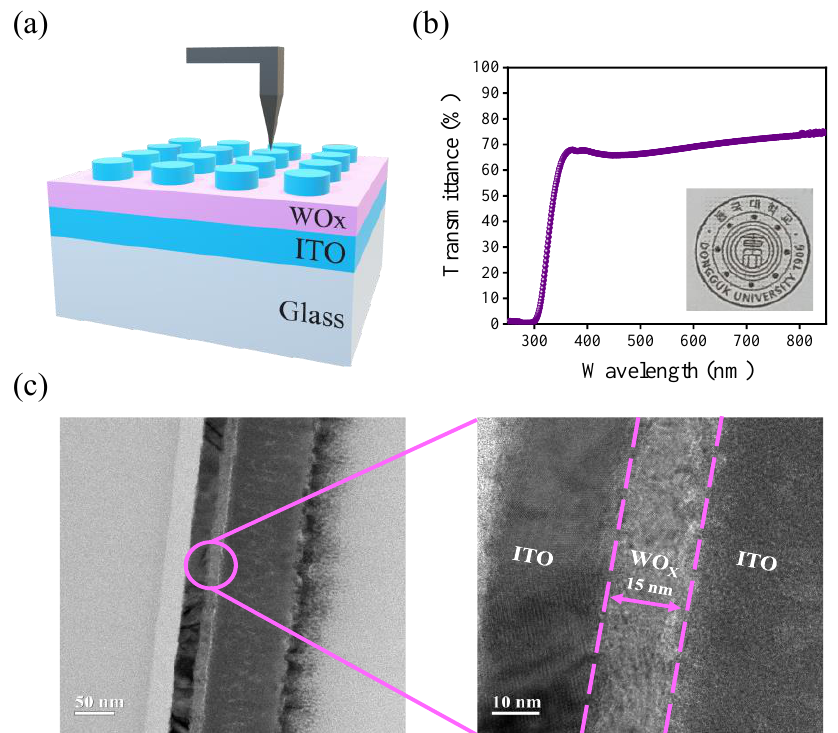
Figure 1. ( a ) Schematic image of ITO/WO x /ITO device. ( b ) Optical transmittance spectrum measured using a spectrophotometer in the visible wavelength region. Inset image shows the transparency of the fabricated device. ( c ) Low and high magnification imaged by TEM.